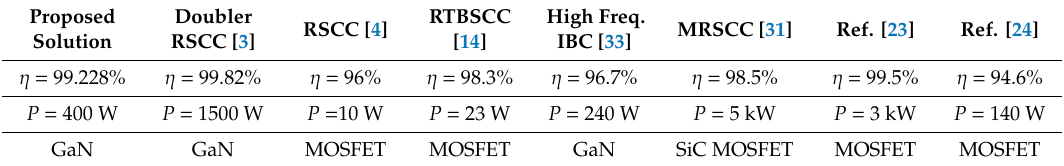
Table 5. Comparison of the maximum efficiencies of selected converters presented in recently published papers.